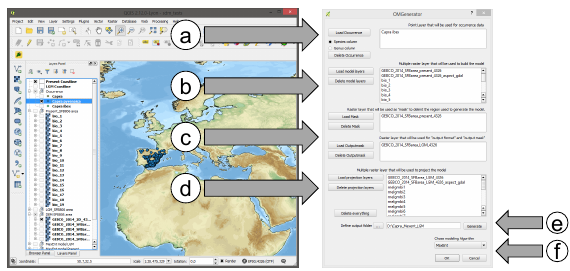
Figure 3: Workflow of the Plugin. (a) This defines multiple oc- currence data layers, for every instance a request.txt and a occur- rence.txt is generated. (b) Defines the data that will be used to build the model. (c) Defines the raster datasets that are used as ”Mask” or ”Output format” & ”Output mask”. (d) These layers will be used to project the model. (e) Defines the destination path.